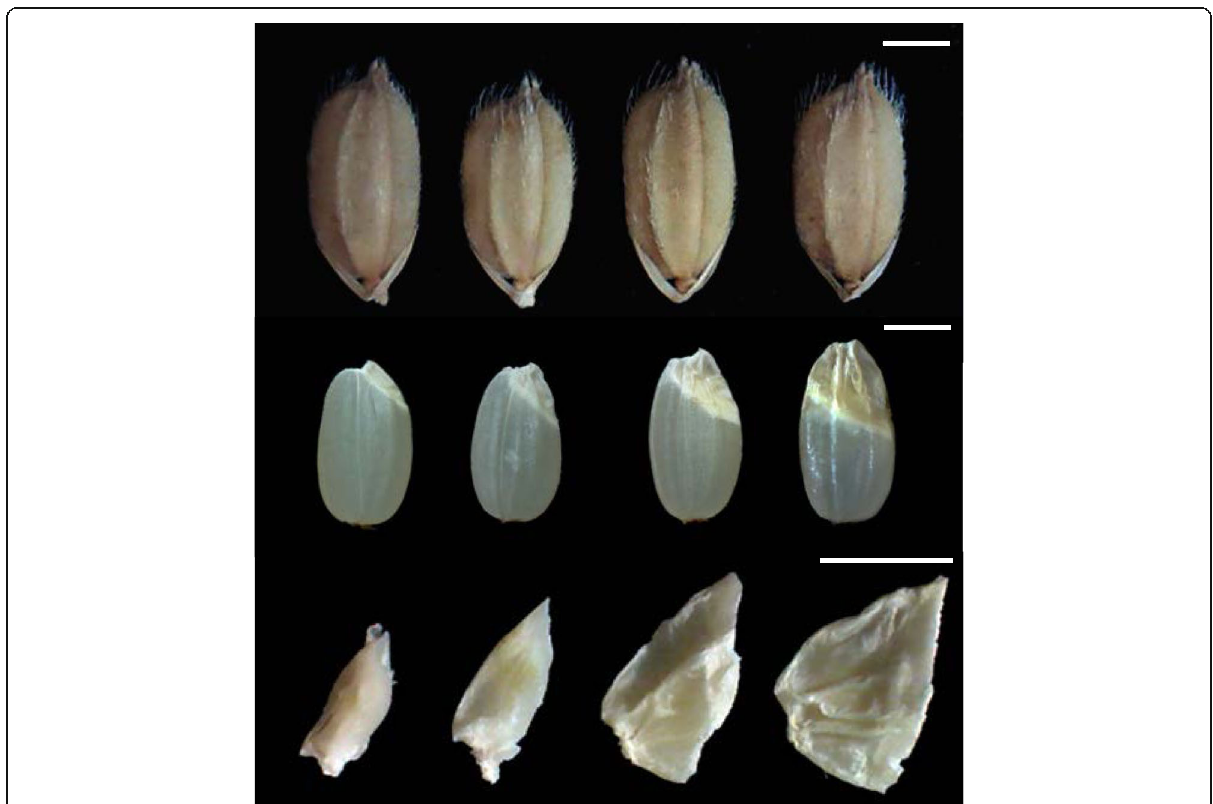
Fig. 1 Grain and embryo phenotypes of HC and giant embryo mutants. Images from left to right are of HC, le , ge , and ge s in this order. Scale bars = 2 giant embryo mutants, ge and ge s , showed three different embryo phenotypes with 9:3:4 segregation ratio (normal type: le type: ge / ge s type) (Additional file 4: Figure S3), suggesting that LE is not allelic to GE .